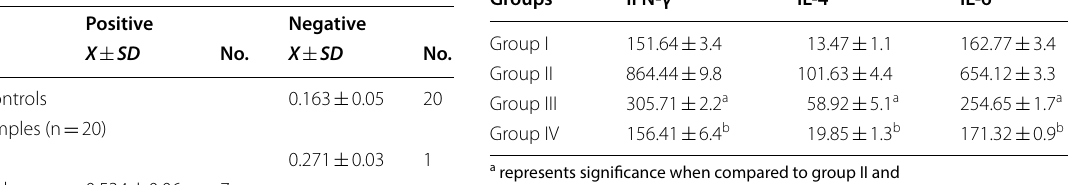
Table 4 Detection of G. duodenalis cyst antigens in water samples by sandwich ELISA